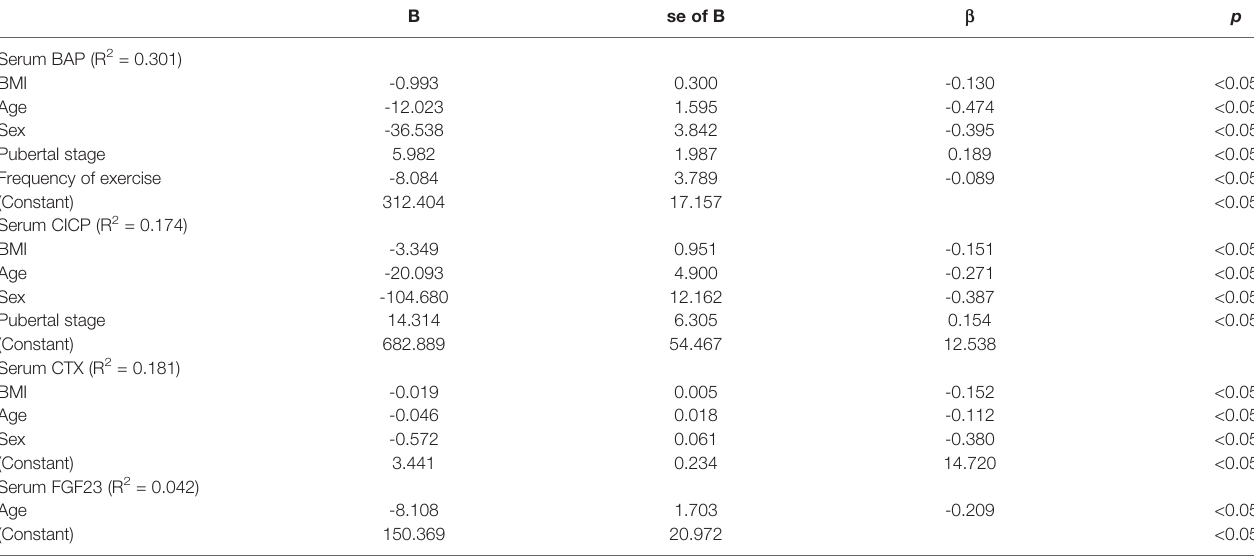
TABLE 2 | Multiple regression analysis for the variables independently related to serum BTMs and FGF23 levels in all subjects. B se of B b p Serum BAP (R 2 = 0.301) BMI